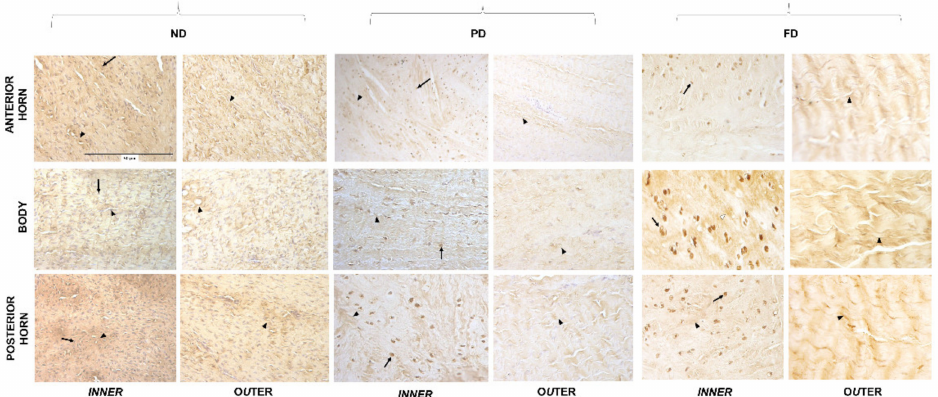
Figure 2. ( A ) Meniscal partition scheme: menisci were subdivided transversally (in an anterior horn, a body, and a posterior horn) and longitudinally, in an inner and an outer part; Western blot results for collagen type I ( B ) with GAPDH and subsequent calnexin as housekeeping; Western blot results for aggrecan ( C ) with GAPDH and subsequent calnexin as housekeeping. ND: not developed; PD partially developed; FD: fully developed. Values with ** and * differ for p < 0.01 and p < 0.05, respectively.